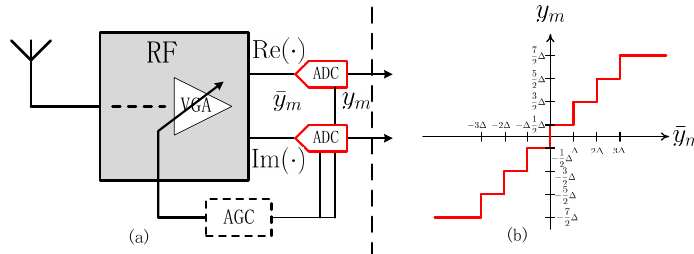
Figure 1. A quantized system with few-bit ADC. ( a ) Radio frequency (RF) architecture on receiver side. ( b ) An example of b = 3 -bit